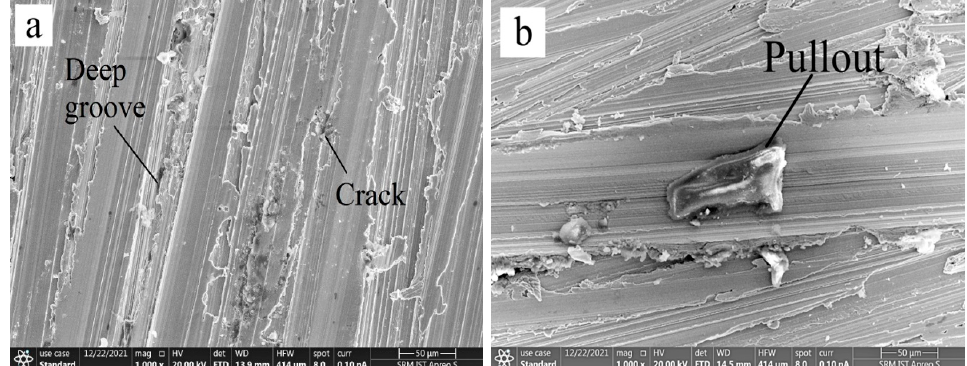
Figure 6. Wear morphology of DCT2 sample showing ( a ) cracks and ( b ) deep grooves.